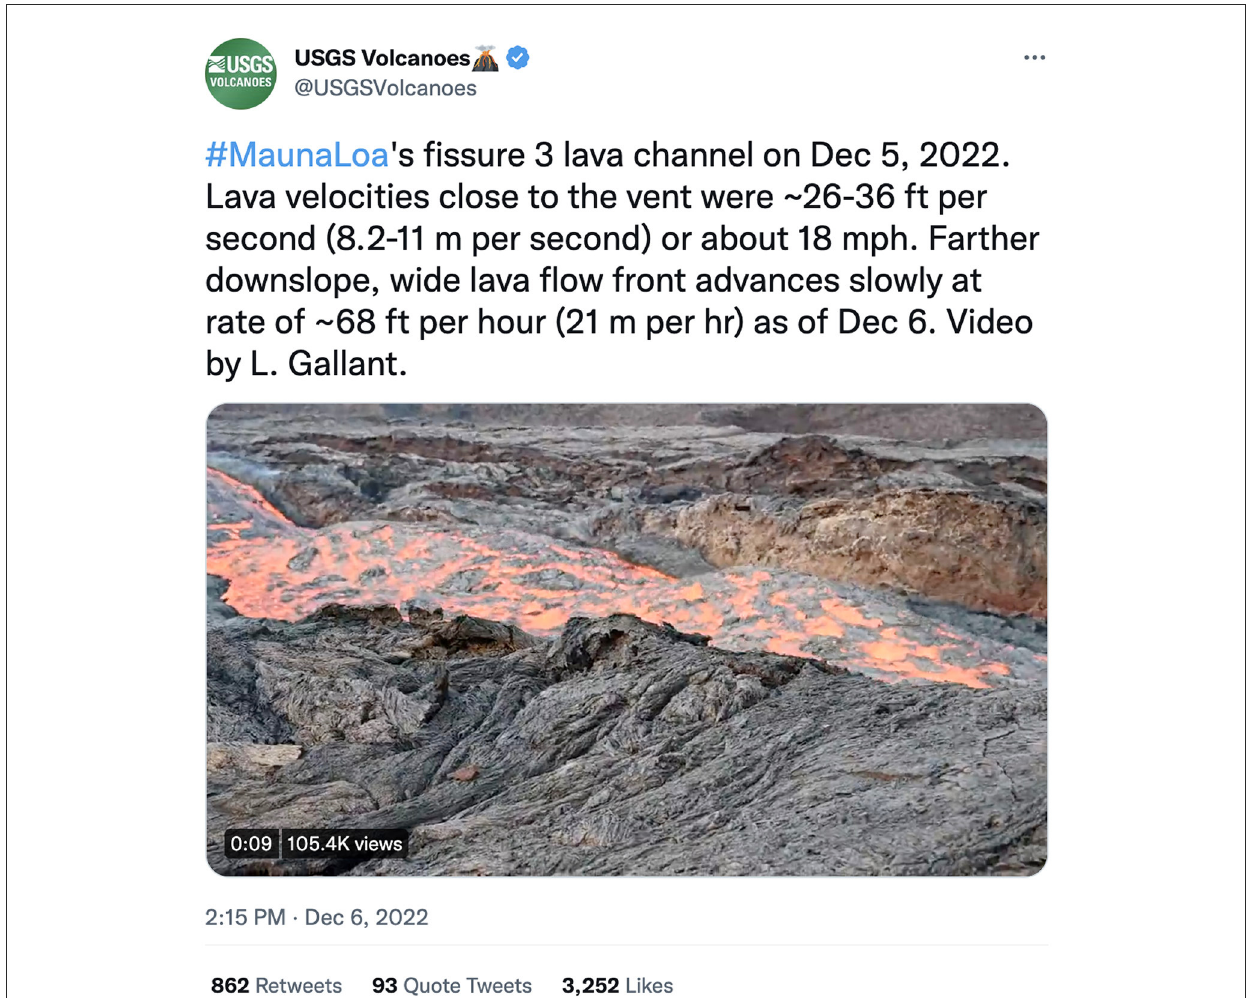
FIGURE9 Image of one of the most popular tweets from the Mauna Loa eruption. This video a , published first on the HVO website, was viewed over 105,000 times and shows the rapid movement of lava through a channel fed by Fissure 3. a